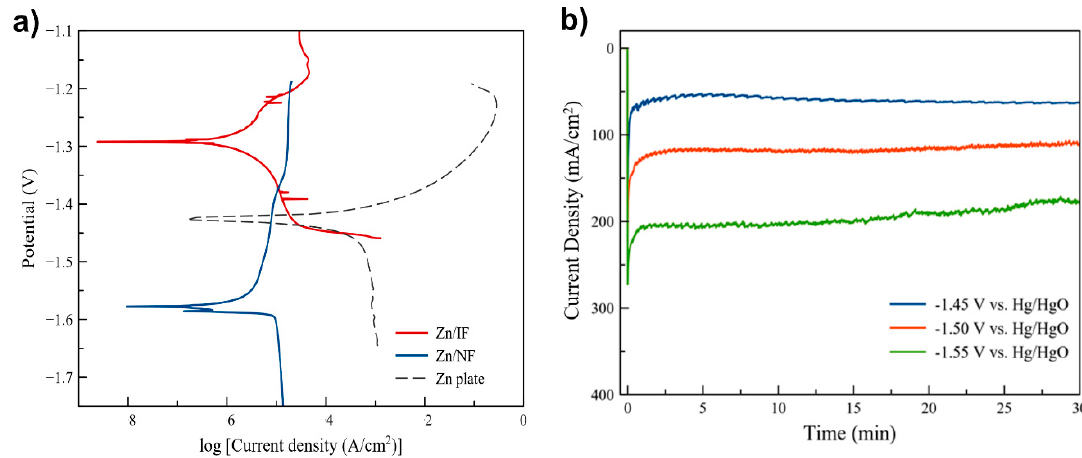
Figure 5. ( a ) Potentiodynamic polarization (Tafel) curves of the pure Zn plate, Zn/IF and Zn/NF anodes, at a scan rate of 1.67 mV/s. ( b ) Chronoamperometry of the Zn/IF electrode within a potential − 1.45 to − 1.60 V vs. Hg / HgO in an electrolyte range of − 1.45 to − 1.60 V vs. Hg/HgO in an electrolyte solution.